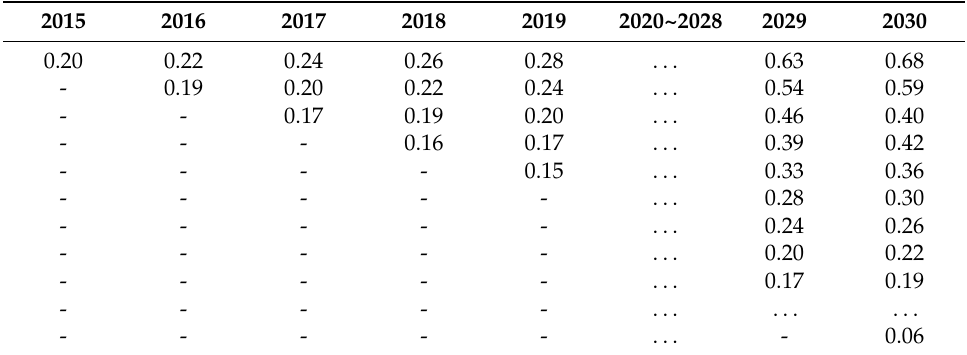
Table 1. Binary tree stochastic process of thermal power generation cost (yuan/kwh).